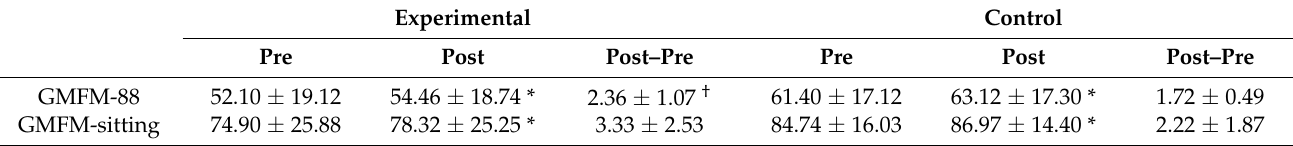
Table 6. Comparison of gross motor function (unit: